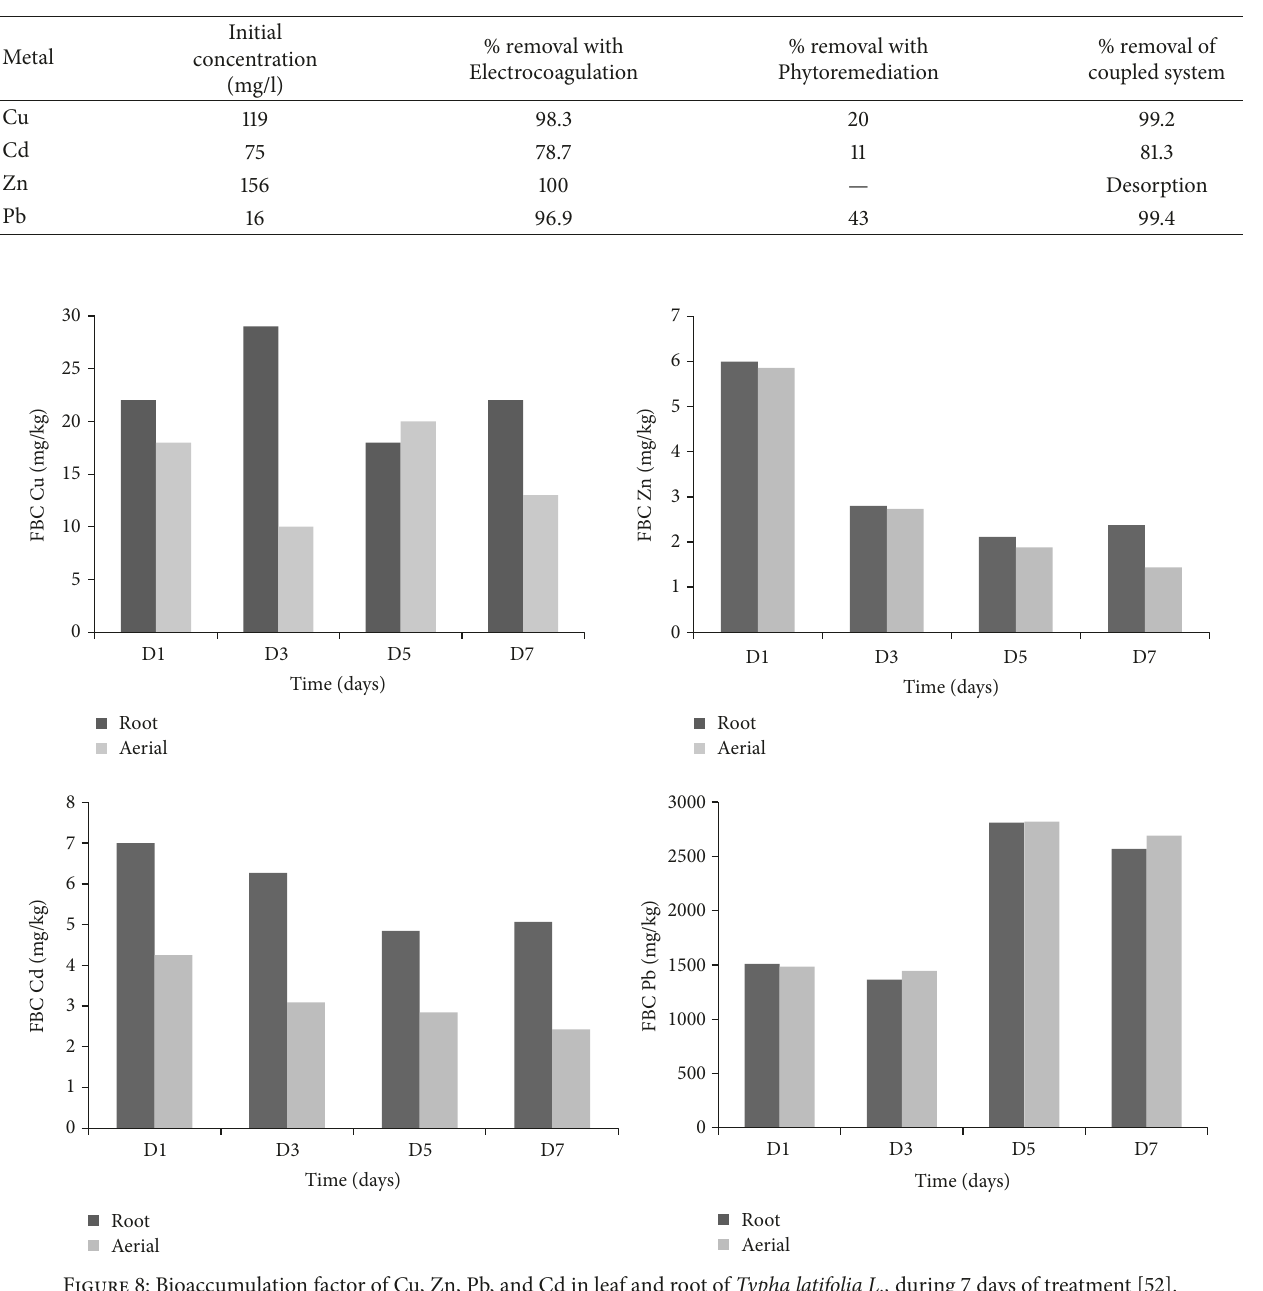
Table 3: Efficiency in the removal of the heavy metals by the coupled process of electrocoagulation and phytoremediation [52].